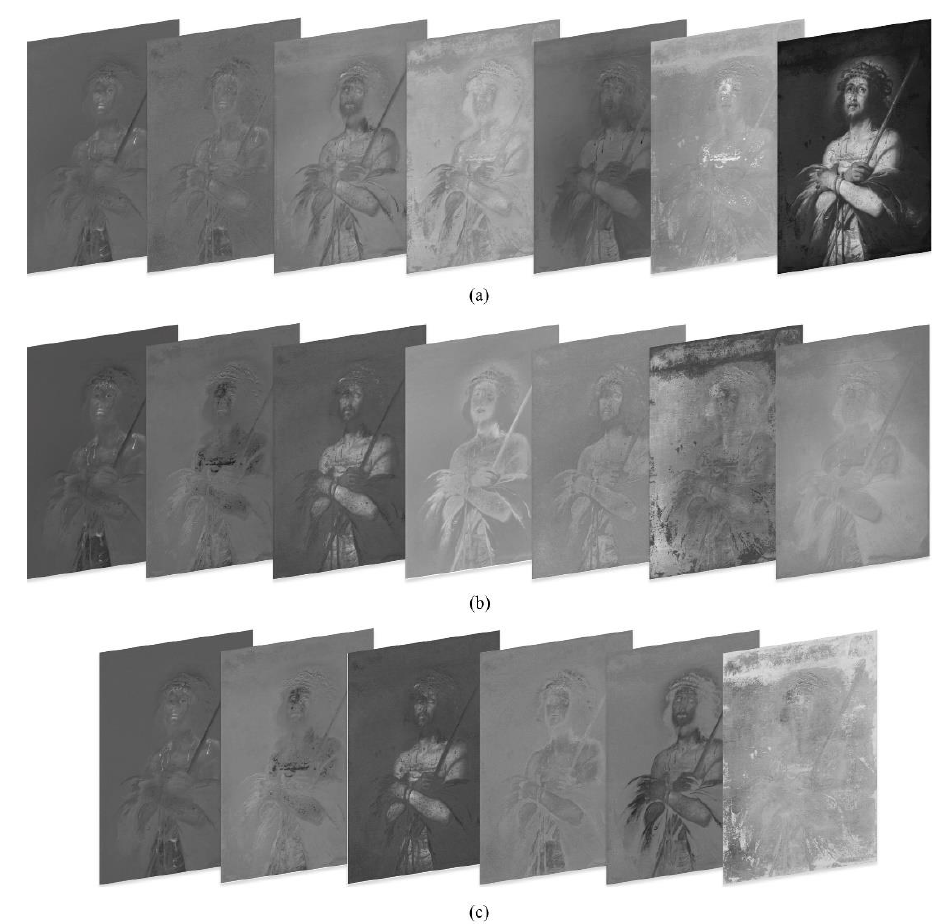
Figure 3. Phase I, stage 2: ( a ) Output channels obtained by principal component analysis (PCA) from the entire data set in Figure 2; ( b ) Output channels obtained by independent component analysis (ICA) from the entire data set in Figure 2; ( c ) Output channels obtained by ICA from the multispectral cube with no IR data in Figure 2a,b,d,e.